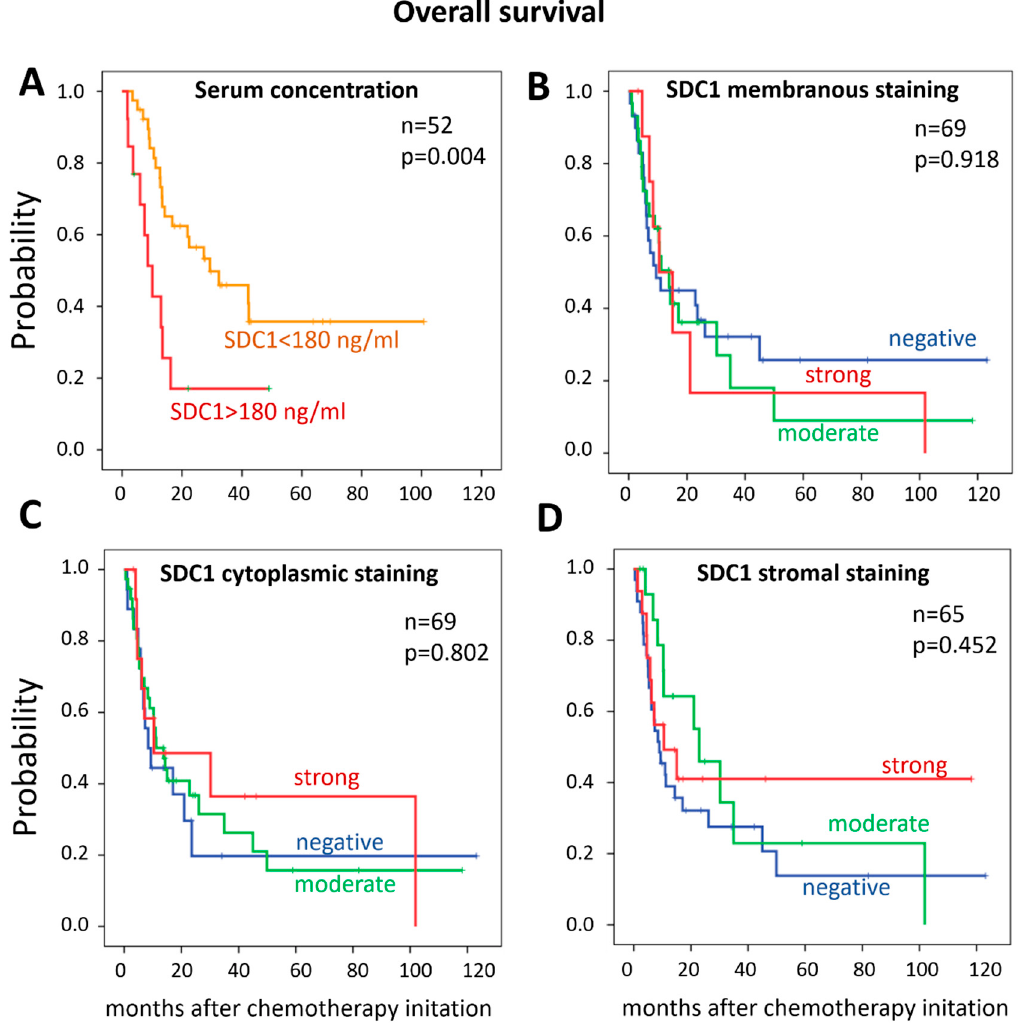
Figure 2. Kaplan–Meier curves of overall survival stratified by ( A ) SDC1 serum concentration ( > 180 ng / mL) and SDC1 tissue expression, ( B ) SDC1 membranous staining, ( C ) SDC1 cytoplasmic staining, ( D ) SDC1 stromal staining.